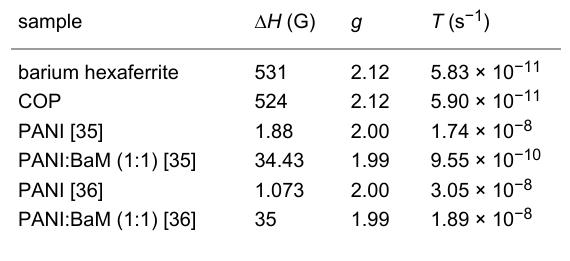
Table 2: ESR parameters of barium hexaferrite and COP taken at room temperature in X band.